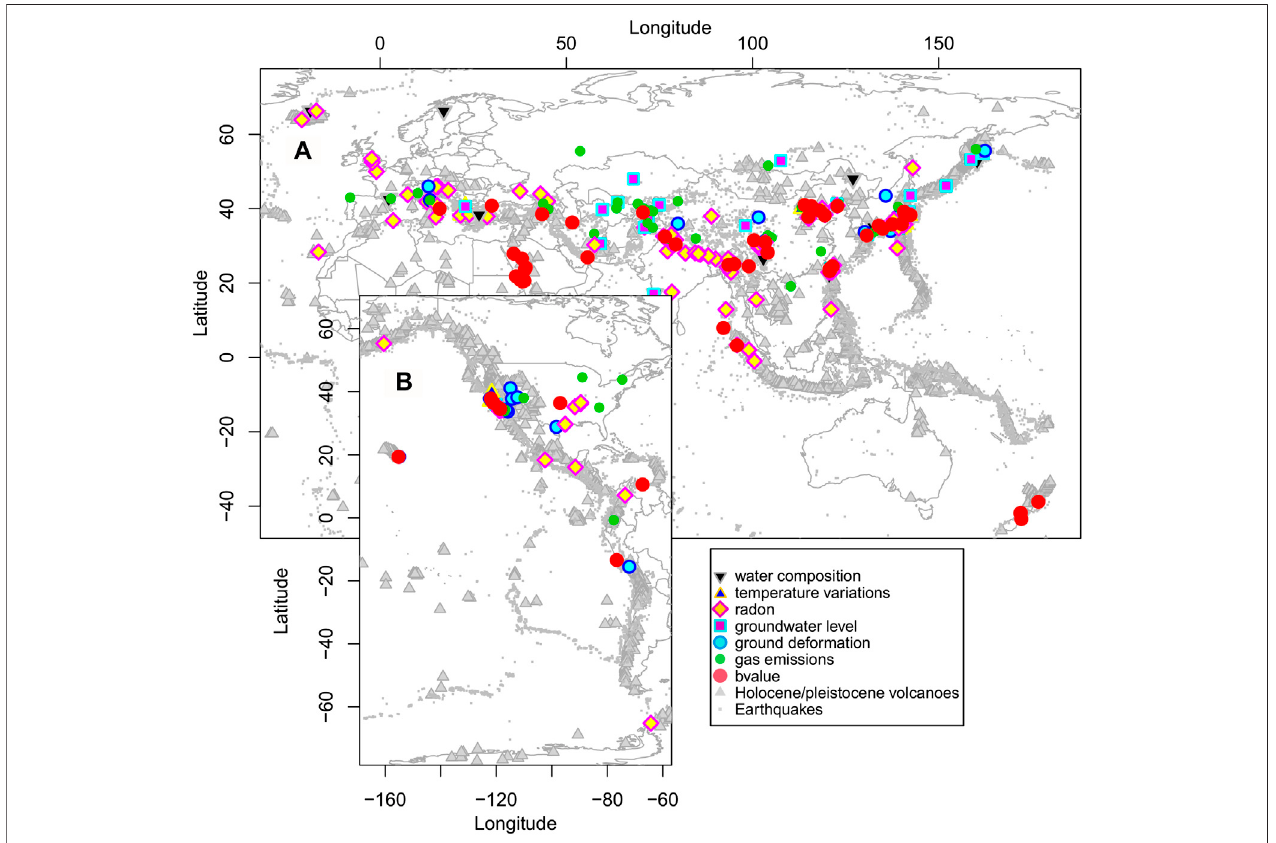
FIGURE 1 | Global distribution of the seismic precursors cataloged in this work and divided into seven typologies. Holocene/Pleistocene volcanoes and earthquakes from the ISC catalog are also shown.